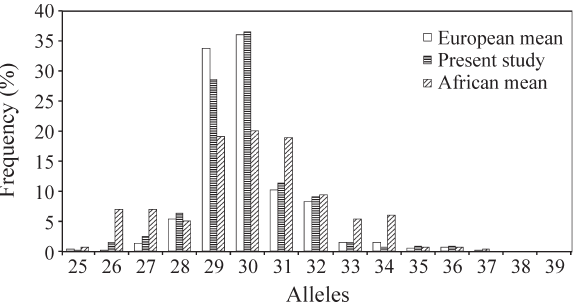
Figure 1 - Allele frequencies of the SCA1 locus in three population sam- ples. The European and African means were calculated from Watkins et al . (1995); Jodice et al. (1997); Limprasert et al . (1997); Takano et al . (1998).